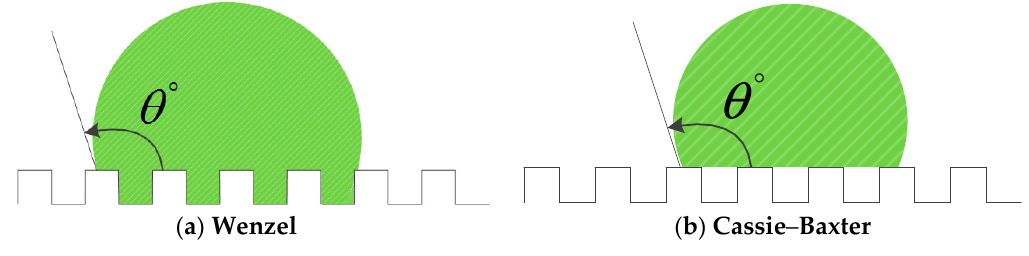
Figure 6. Wenzel model and Cassie model.